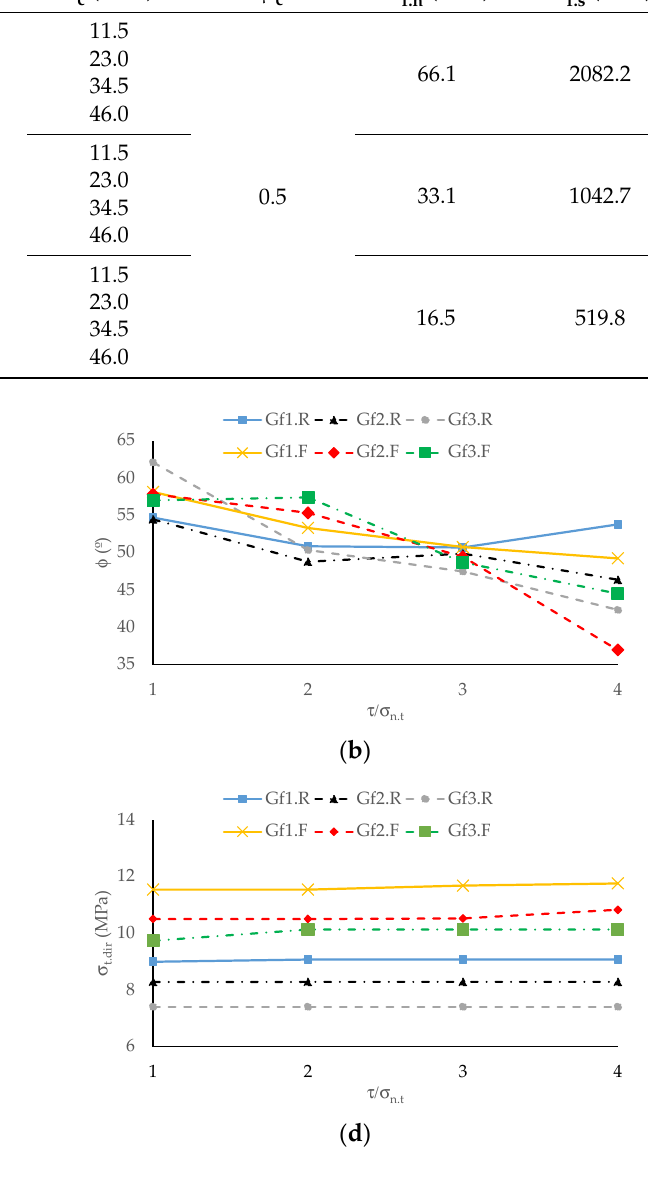
Table 5. Strength properties for the particle models: Influence of contact strength. Case